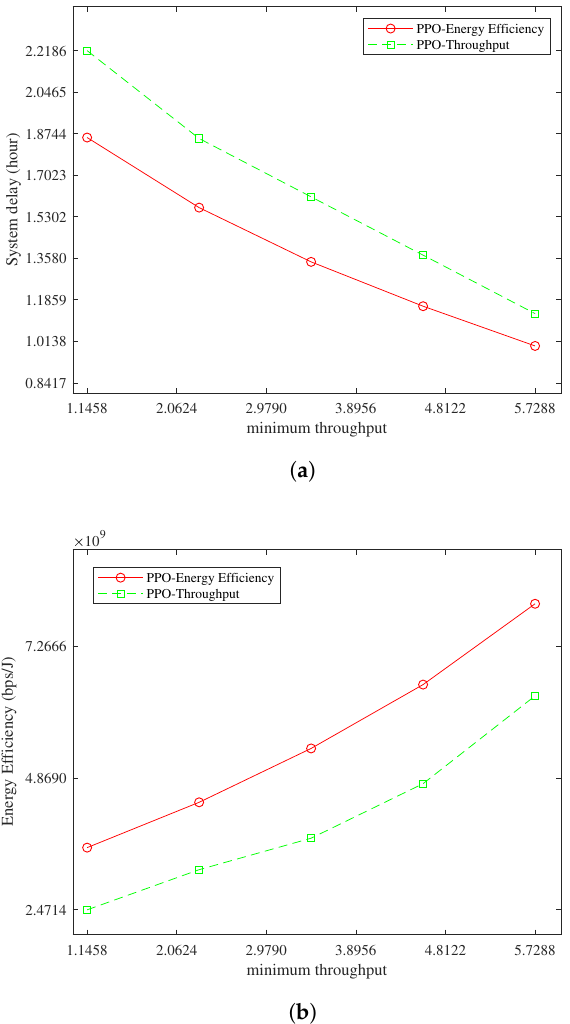
Figure 5. System performance with minimum throughput: ( a ) System delay with minimum through- put; and ( b ) Energy efficiency with minimum